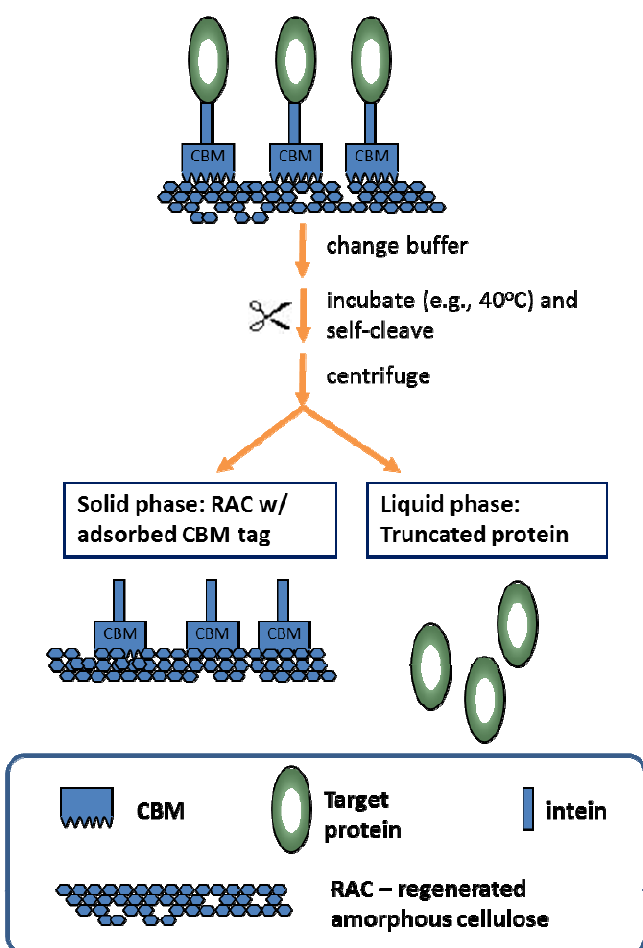
Figure 5. Scalable protein purification based on affinity adsorption of cellulose-binding module (CBM)-tagged protein on low-cost cellulosic absorbent followed by intein self-cleavage